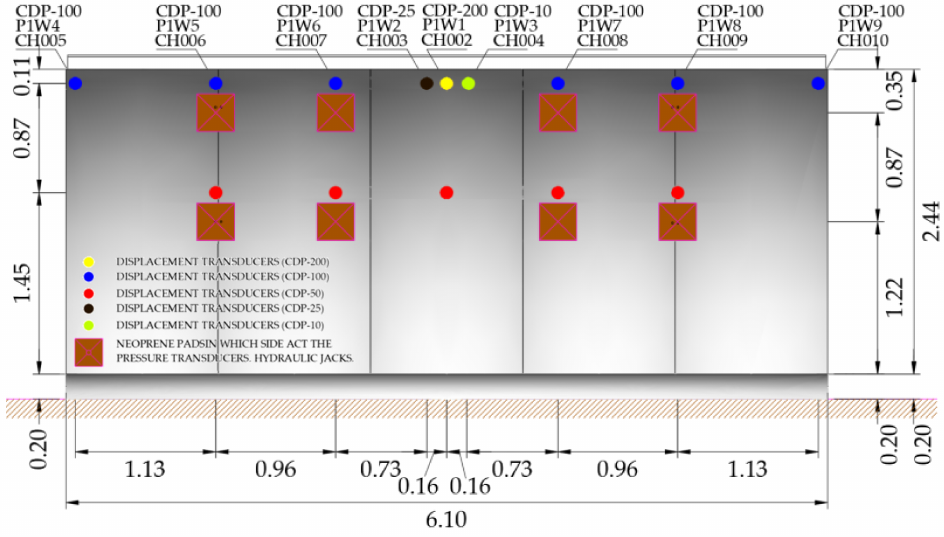
Figure 8. Location and mediation capacities of the displacement transducers.